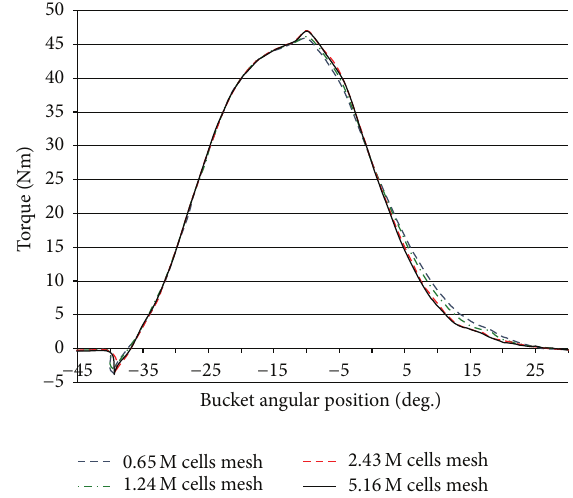
Figure 8: Individual torque curves of mesh refinement simulations.